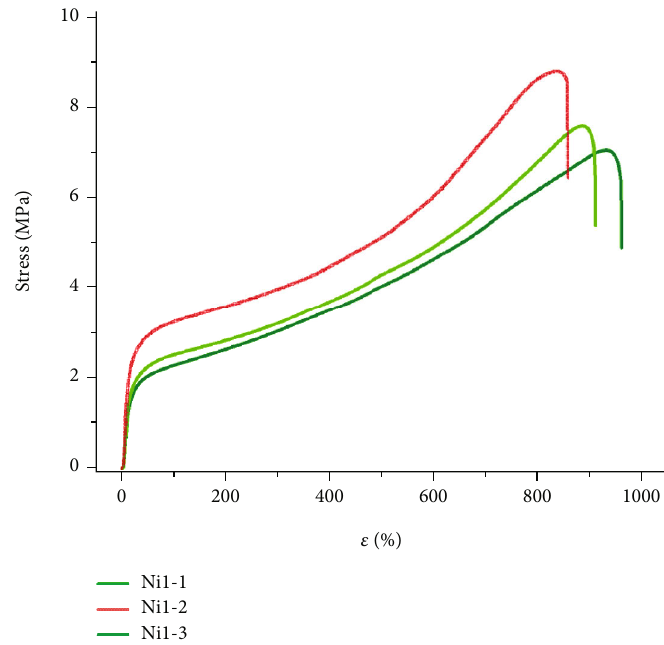
Figure 7: Stress-strain curves for Ni1 polyethylenes.